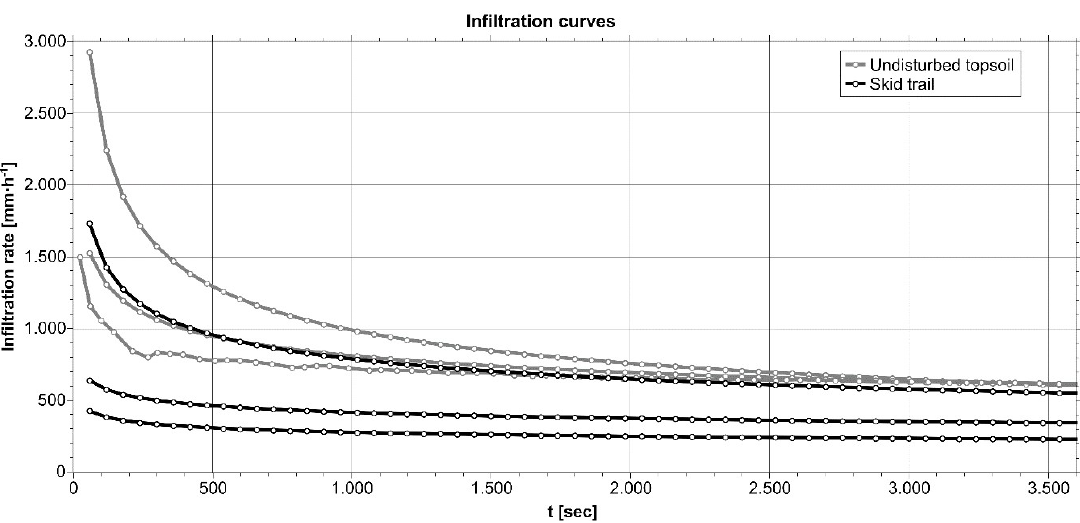
Figure 6. Exemplary infiltration curves for undisturbed topsoil and skid